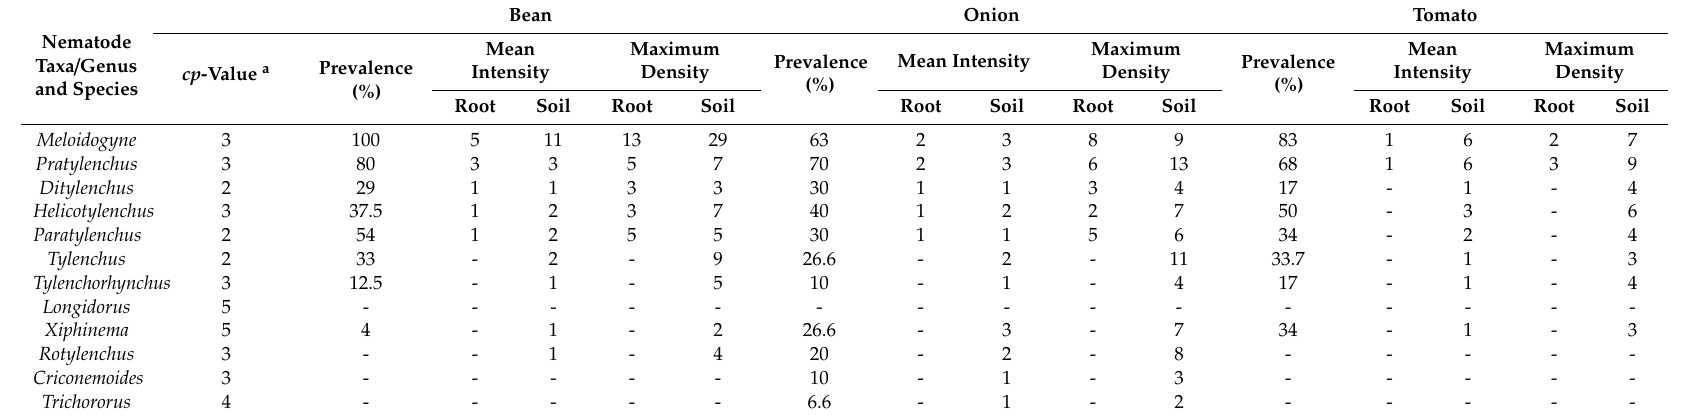
Table 3. Prevalence, mean, and maximum density of plant parasitic nematodes from soil (100 cm 3 ) and root (20 g) of organic vegetable crops in Southern Morocco (survey January